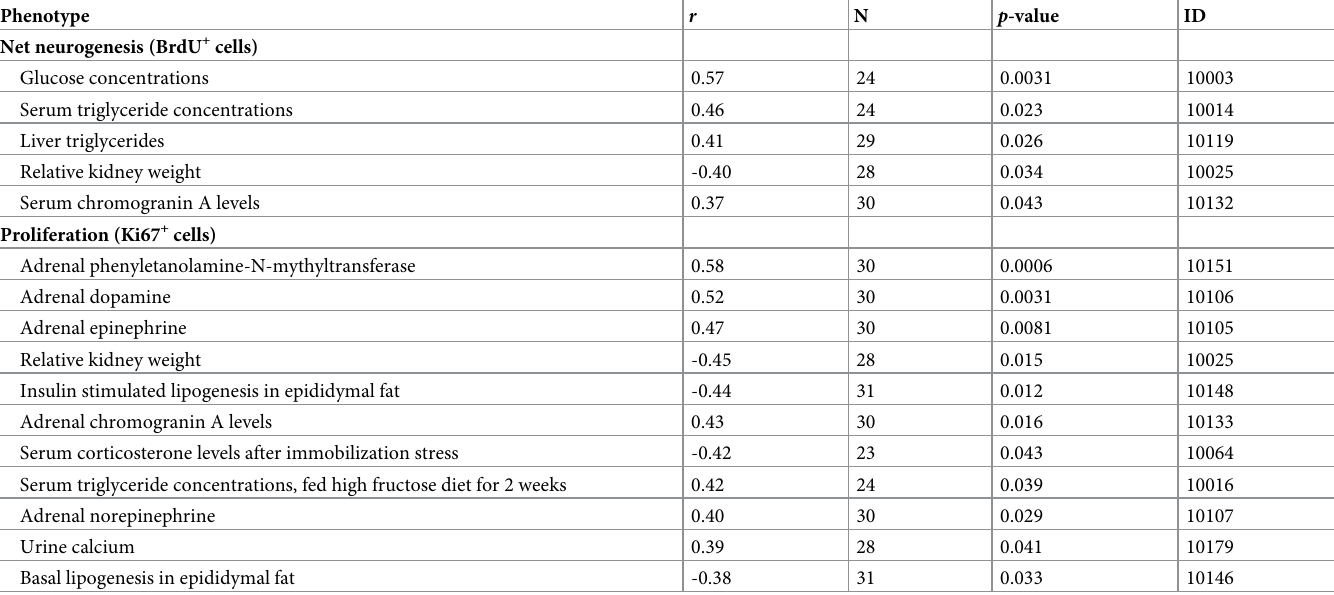
Table 1. Published phenotypes correlating to adult neurogenesis in HXB/BXH family.